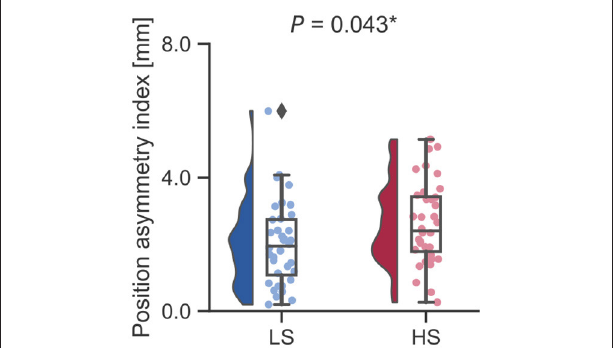
FIGURE 4 | Between-group comparison of the position asymmetry index. The position asymmetry index was significantly higher in the HS group than in the LS group (LS: mean, 2.0; 95% CI, 1.6 to 2.4; HS: mean, 2.6; 95% CI, 2.2 to 3.0; two-tailed Welch’s t -test, P = 0.043). * P < 0.05. A Diamond represents an outlier.